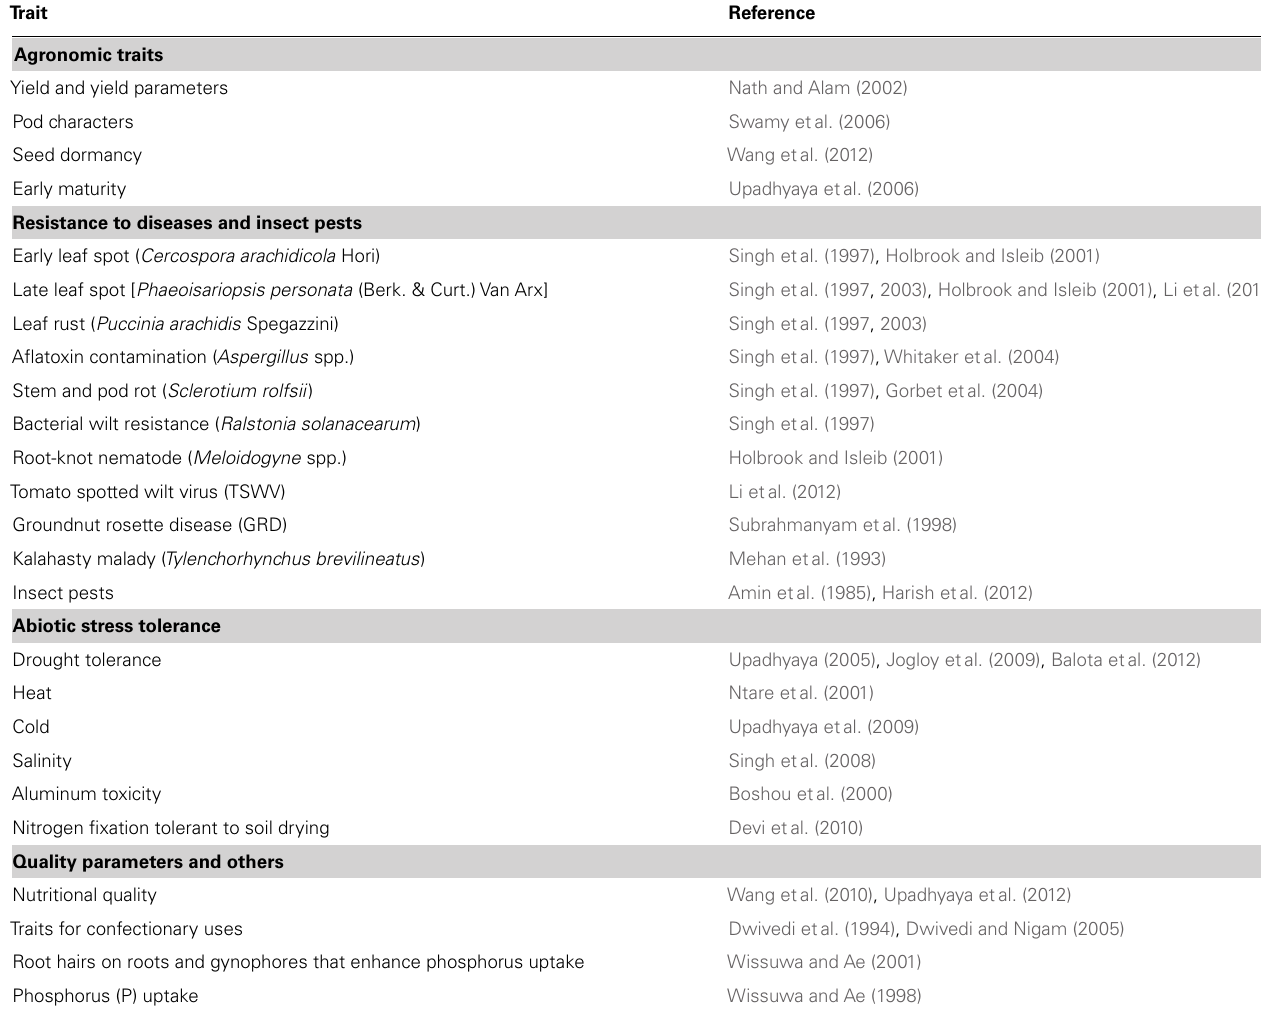
Table 1 | List of important traits in groundnut for which variability was reported in